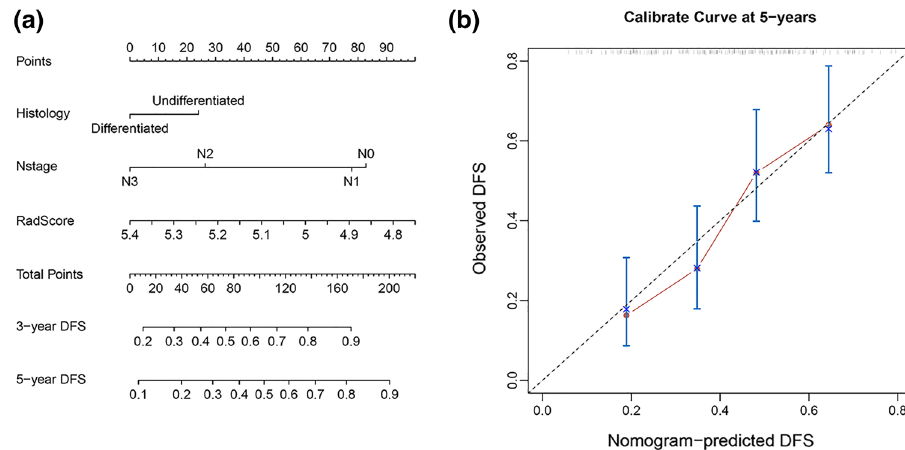
Fig. 5 a Nomogram to predict risk of 5-year disease